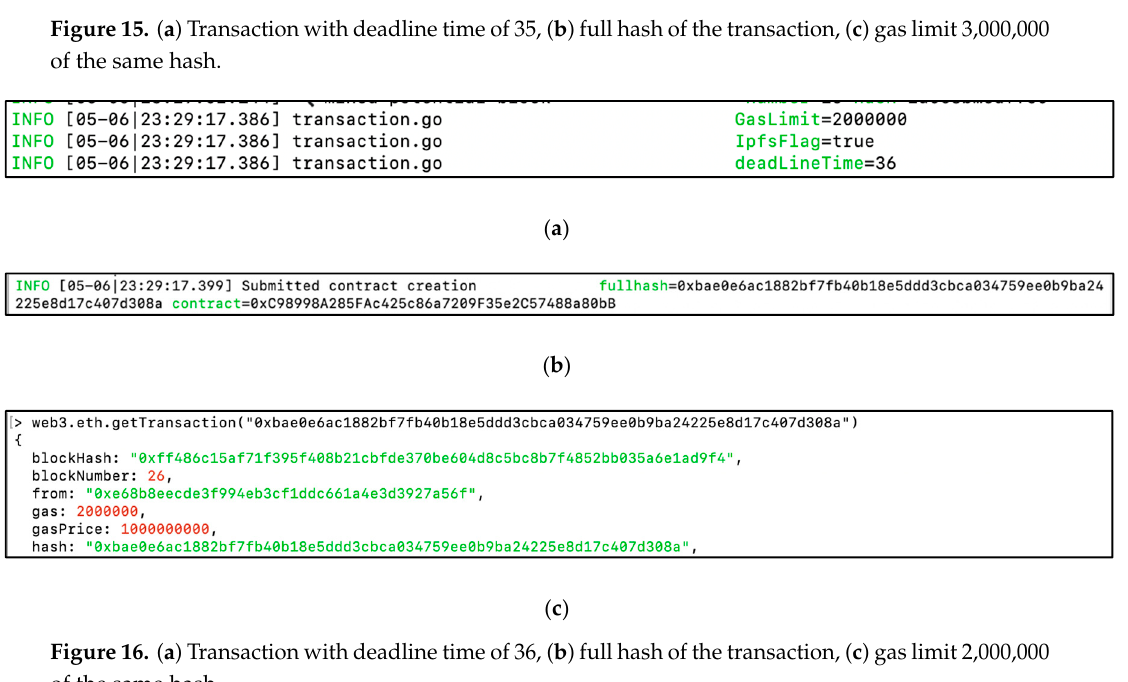
Figure 15. ( a ) Transaction with deadline time of 35, ( b ) full hash of the transaction, ( c ) gas limit 3,000,000 of the same hash.